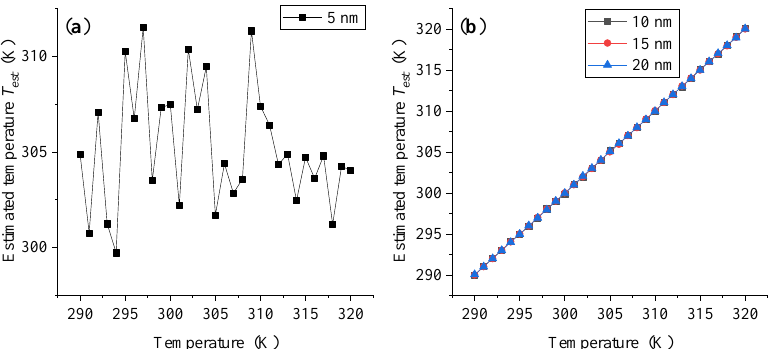
Figure 4. Estimated temperature T est of MNPs with different sizes at different temperature points when H 0 = 600 Oe.